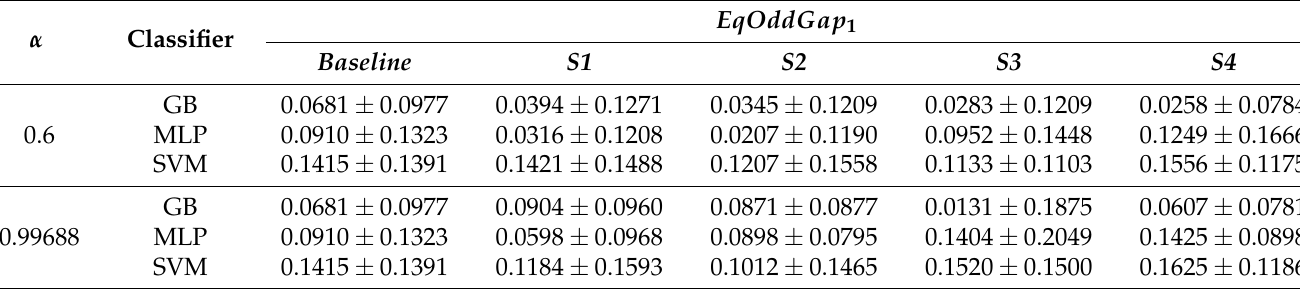
Figure A4. Fairness metrics evaluated for different scenarios on the German credit dataset. Table A7 summarizes the results obtained on these 4 scenarios for values of α that correspond to points A and B . Table A7. GANSan quantitative results on german credit